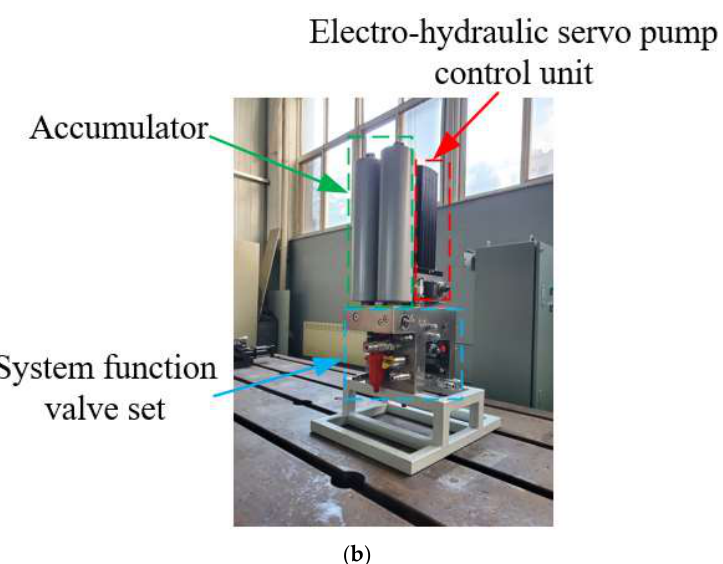
Figure 18. System test platform. ( a ) Hydraulic cylinder loading platform. ( b ) Pump control integrated unit.